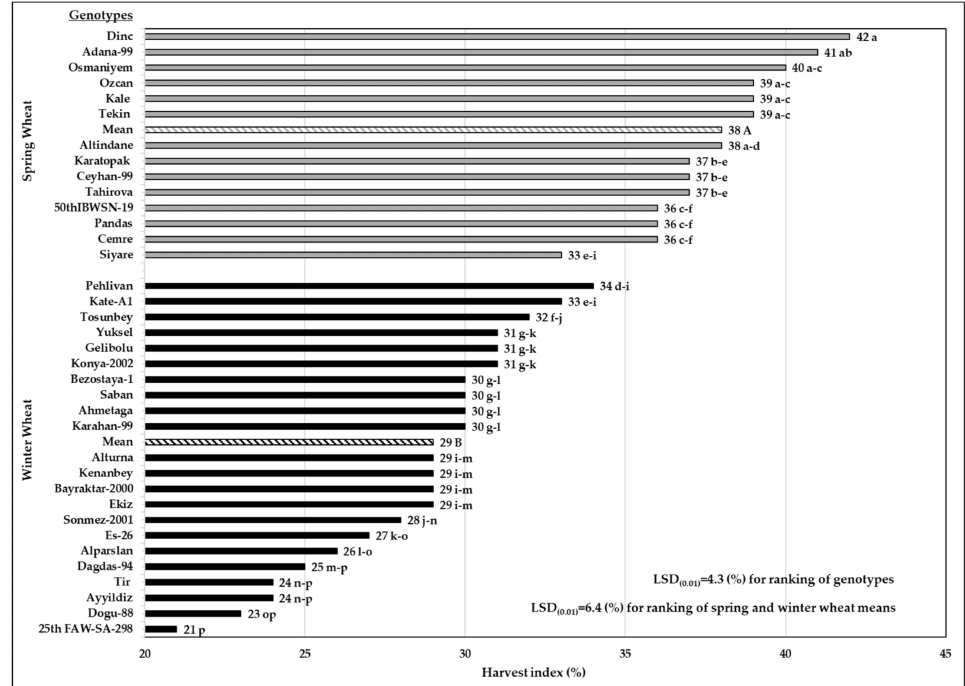
Figure 5. Comparing winter wheat genotypes with spring wheat genotypes for harvest index (%) over two cropping seasons. Genotypes with the same letter are not significantly different.